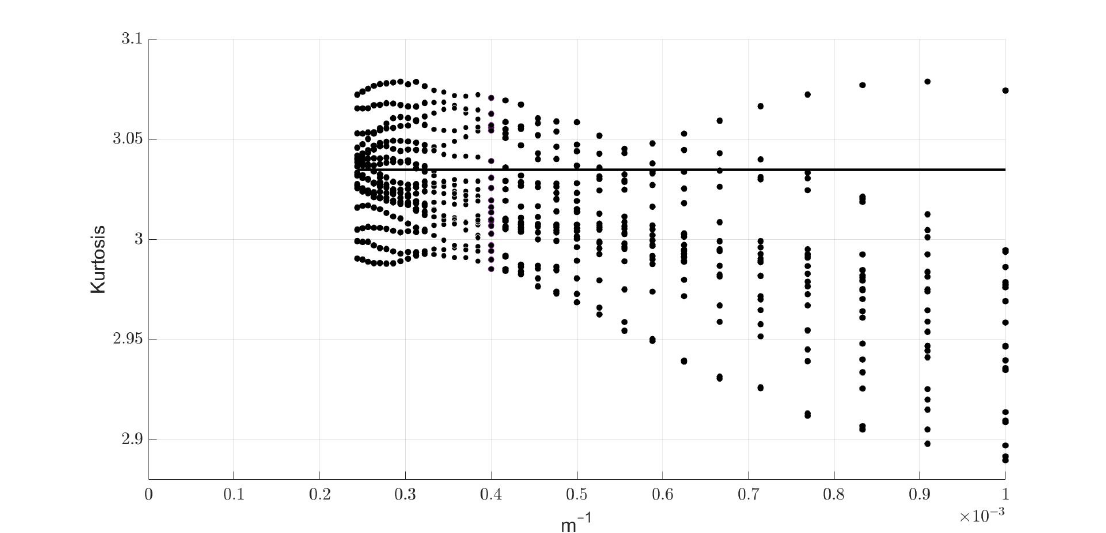
Figure 12. Same as Figure 11 with a semi-log